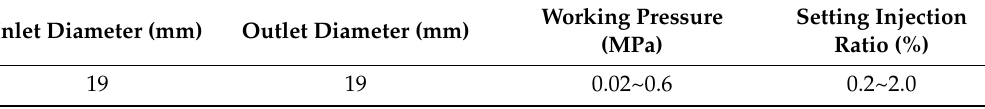
Table 1. Technical